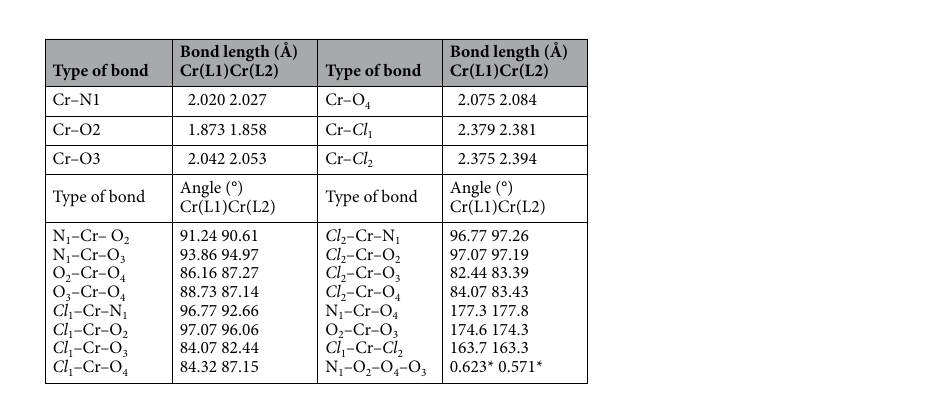
Table 7. Bond angles (°) and important optimum bond lengths (Å) of [Cr(L1)(H 2 O) 2 Cl 2 ] and [Cr(L2) (H 2 O) 2 Cl 2 ]. *dihedral